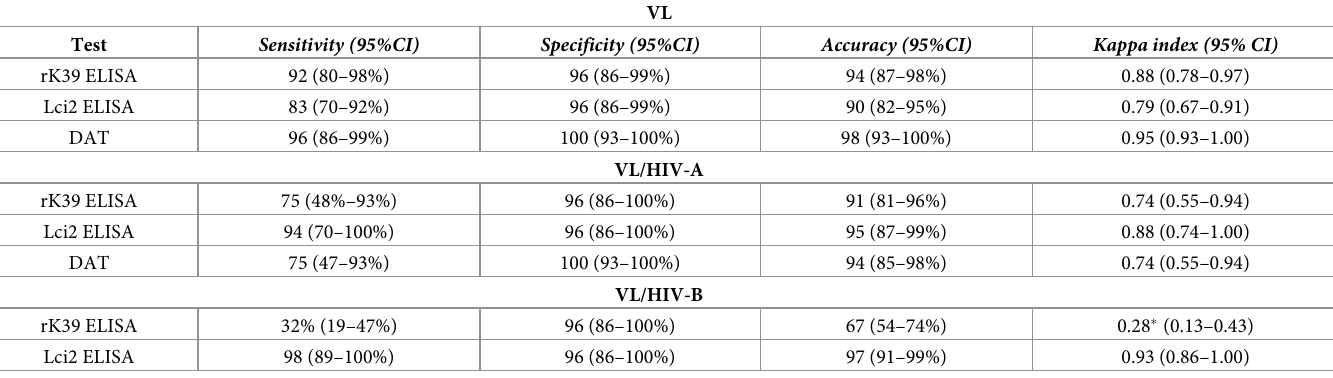
Considering the poor performance previously reported for rK39 when it was used for the VL diagnosis in VL/HIV coinfections [14], we compared both Lci2 with rK39 using a group of VL/HIV sera from patients whose VL diagnosis was parasitologically confirmed (VL/HIV-A). Table 1. Comparative analysis of the diagnostic performance of the ELISA assays based on the rK39 and Lci2 recombinant proteins as well as DAT. Sera from patients belonging to both VL or VL/HIV groups were